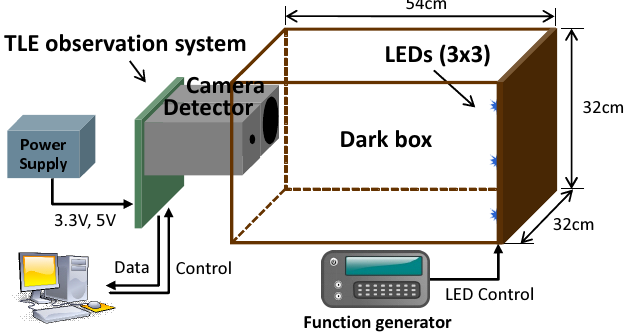
Figure 12. Diagram of ground simulation setup. Blue jet is emulated by flashing UV LEDs in specific radiant power and